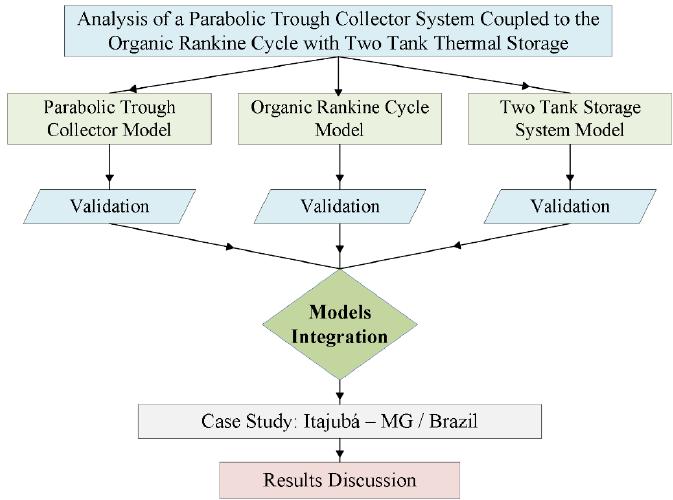
Figure 2. The methodological sequence used to analyze the proposed system configuration.